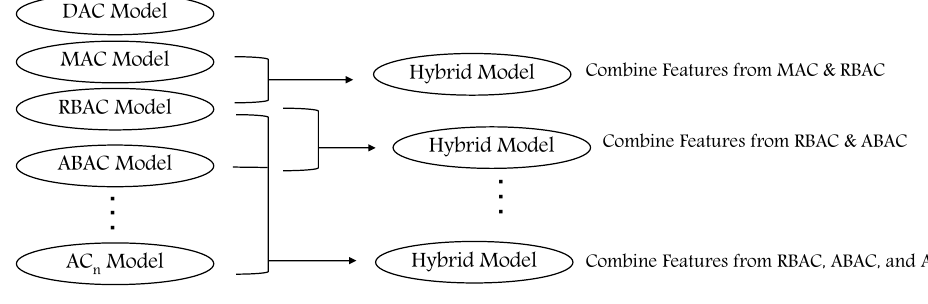
Figure 2. Hybrid AC